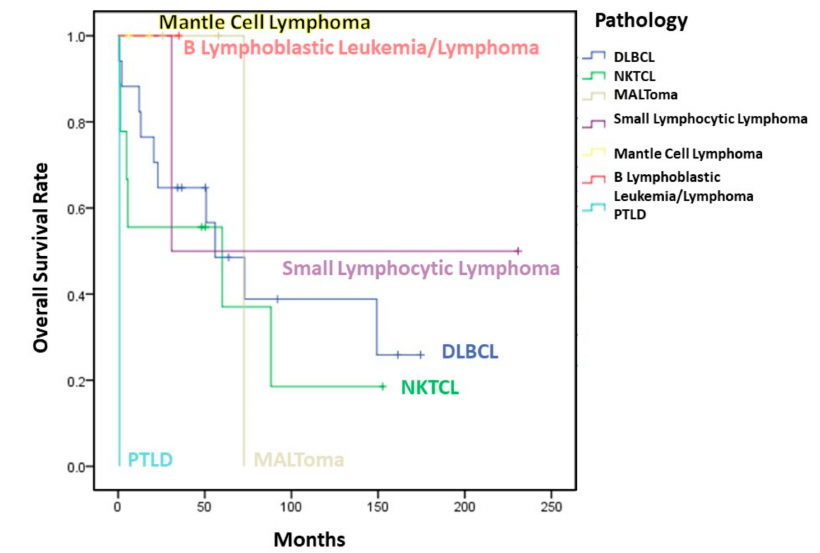
Figure 6. Overall survival of 35 patients with NP lymphoma in our